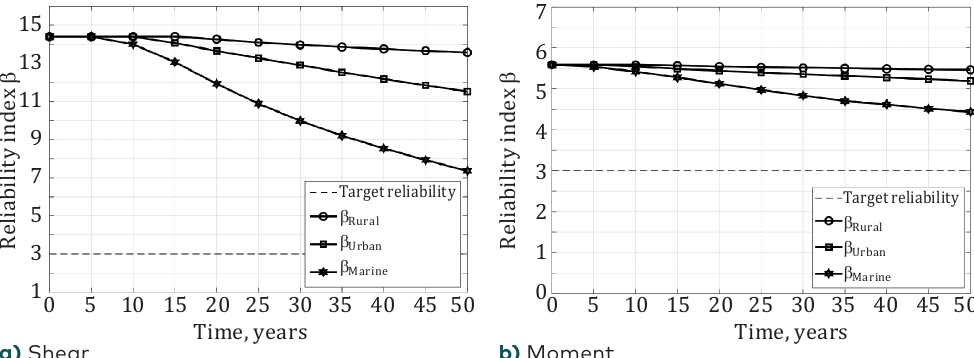
a) Shear b) Figure 13. Life-cycle reliability analysis of the bridge